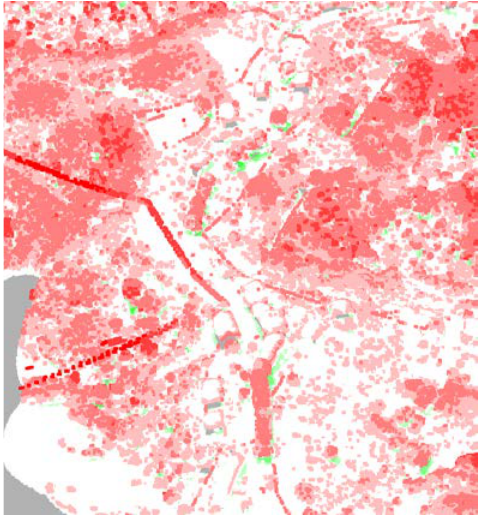
Figure 3: Close-up view of the classified Liguria point set using the surface from Figure 2(a). Features of the data set can clearly be